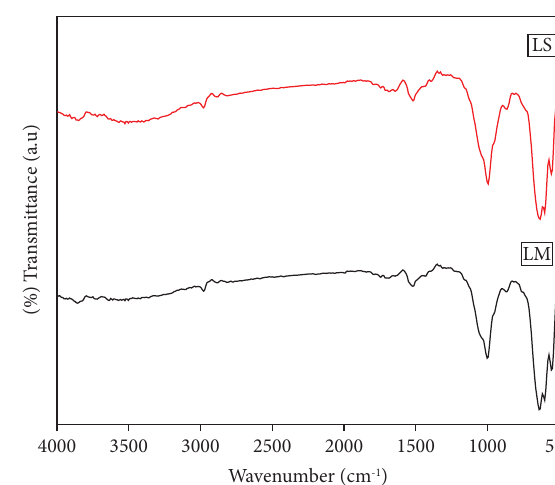
Figure 3: FT-IR spectrum of (a) Li 4 Mn 5 O 12 and (b) Li 4 Mn 4.75 Sm 0.25 O 12